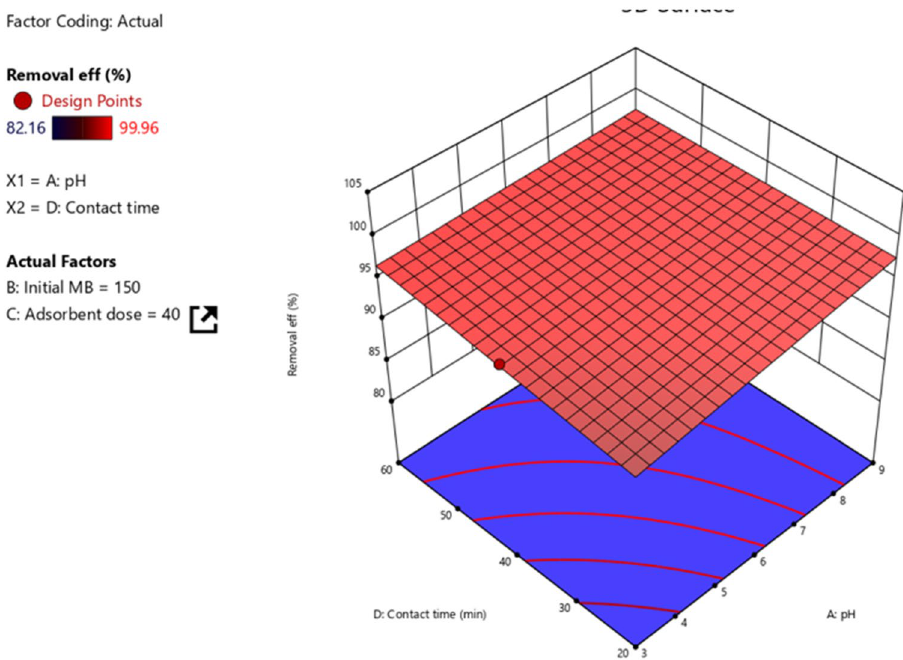
Figure 8. Interaction effect of contact time and